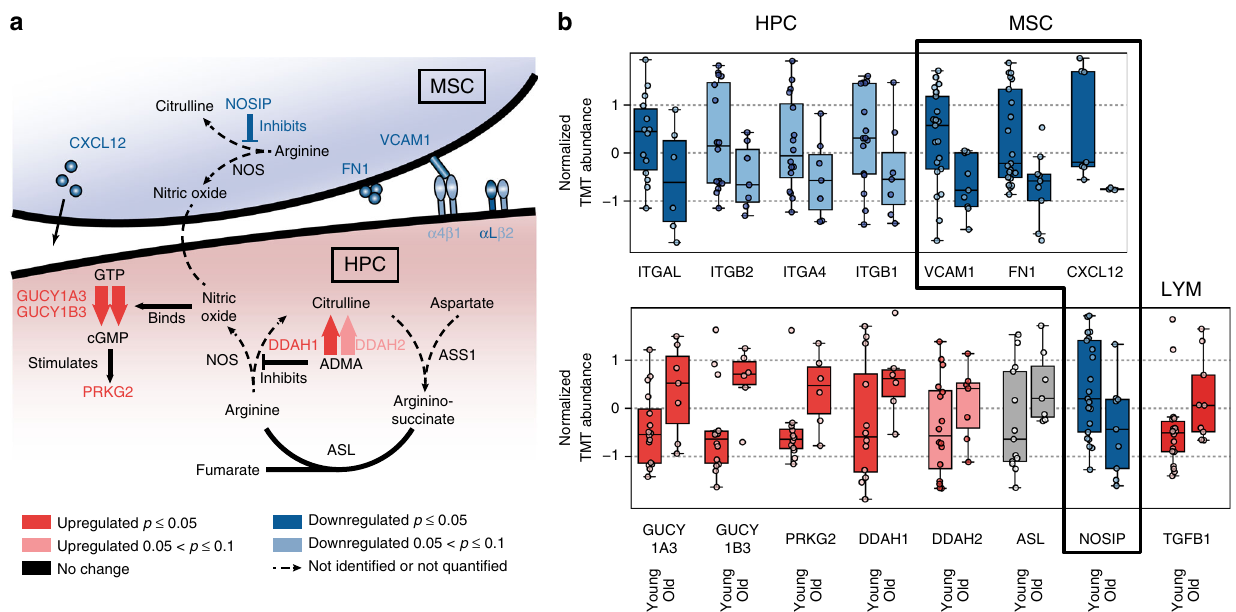
Fig. 8 Alterations of protein abundance in the haematopoietic stem cell niche with age. a CXCL12, VCAM1, and FN1 in MSCs and the integrins alpha4, alphaL, beta1, and beta2 ( α 4, α L, β 1, and β 2) in HPCs decrease in abundance upon ageing. Age-related changes in connection with nitric oxide (NO) synthesis, the urea cycle, and potential NO crosstalk between MSCs and HPCs is depicted by arrows for unidirectional reactions and strokes for bidirectional reactions. Dotted lines or dotted arrows illustrate reactions for which no enzyme was detected or quanti fi ed in this study. The gene names of the respective enzymes are written in capital letters. The colour encodes changes upon ageing, as described in the legend (Spearman's correlation). b Box plot representation of the proteins depicted in a . The dots represent the individual results from younger (age < 30 years) and older (age > 50 years) human subjects. For all box plots, the central line indicates the median, the bottom and top edges of the box the IQR, and the box plot whiskers represent 1.5 times the IQR. Proteins known to have a direct effect on homing or egress of HPCs from or into the bone marrow are shown in the upper and proteins associated with NO signalling and the urea cycle are plotted in the lower graph. An additional box plot depicts the ageing effect on TGFB1 in